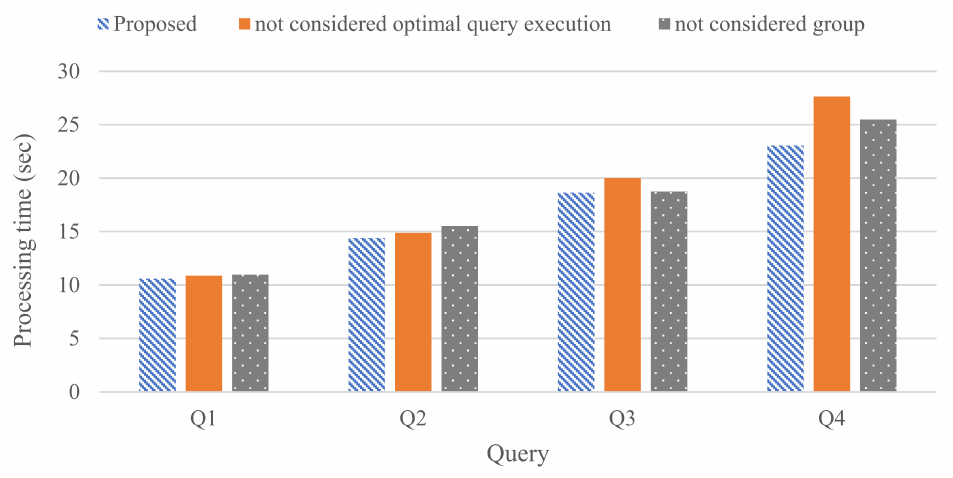
Figure 7. Performance difference by considering query decomposition and query execution